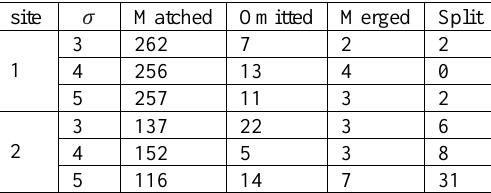
Table 4: The accuracy statistics of the delineation tree crowns using U-Net for test sites 1 and 2. 𝑤 0 was set as